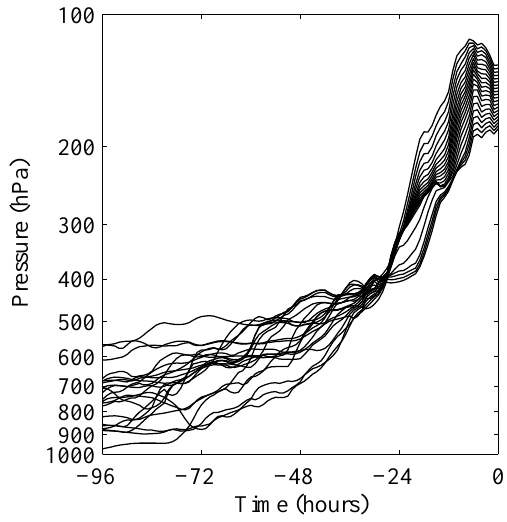
Figure 13. Pressure plot of the HYSPLIT back-trajectories. Zero time is defined as the initialization time of the back trajectories, at 02:00UTC on 22 February